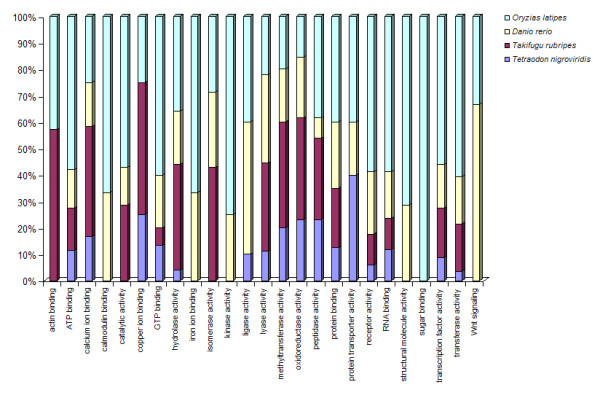
Comparison of rates of gene functions (according to GO) of all fish protein genes with significantly lower distance to the human ortholog than other fish species.